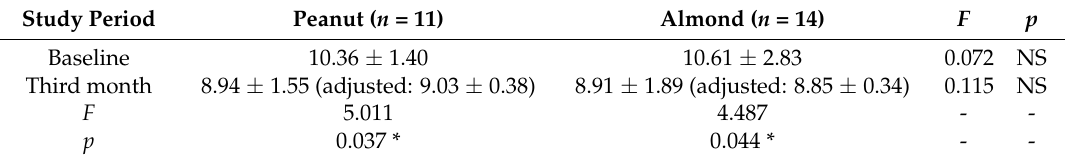
Table 3. Comparison of postprandial 2-h blood glucose (mmol/L) in the two groups.